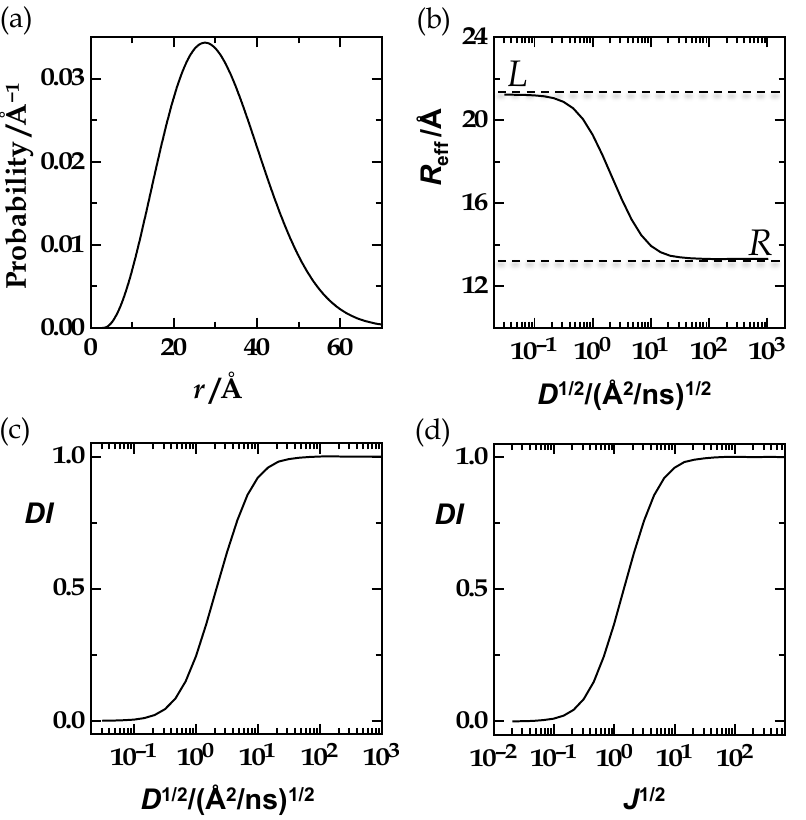
Figure 2. ( a ) An exemplary probability distance distribution of the donor–acceptor distance in a linear (bio)polymer ( b ) The diffusion profile or R eff ( D 1/2 ) profile: Solving the HSE under variation of the diffusion coefficient results in values of the effective distance that range from L to R (dashed lines). The effective distance plotted against D 1/2 approaches R eff = L when the extent of diffusional motion approaches zero and approaches R eff = R when the extent of diffusional motion approaches infinity. ( c ) The diffusion-influence profile or DI ( D 1/2 ) profile is obtained when the diffusion profile shown in ( b ) is normalized with L and R according to DI = ( R eff − L )/( R − L ) (Equation (11)). The diffusion influence, DI , can adapt values between 0 (0%) and 1 (100%). ( d ) The diffusion-influence profile, the DI ( J 1/2 ) or DI ( X ) profile: The diffusion influence plotted against the square root of the augmented diffusion coefficient, X = J 1/2 (see Equation